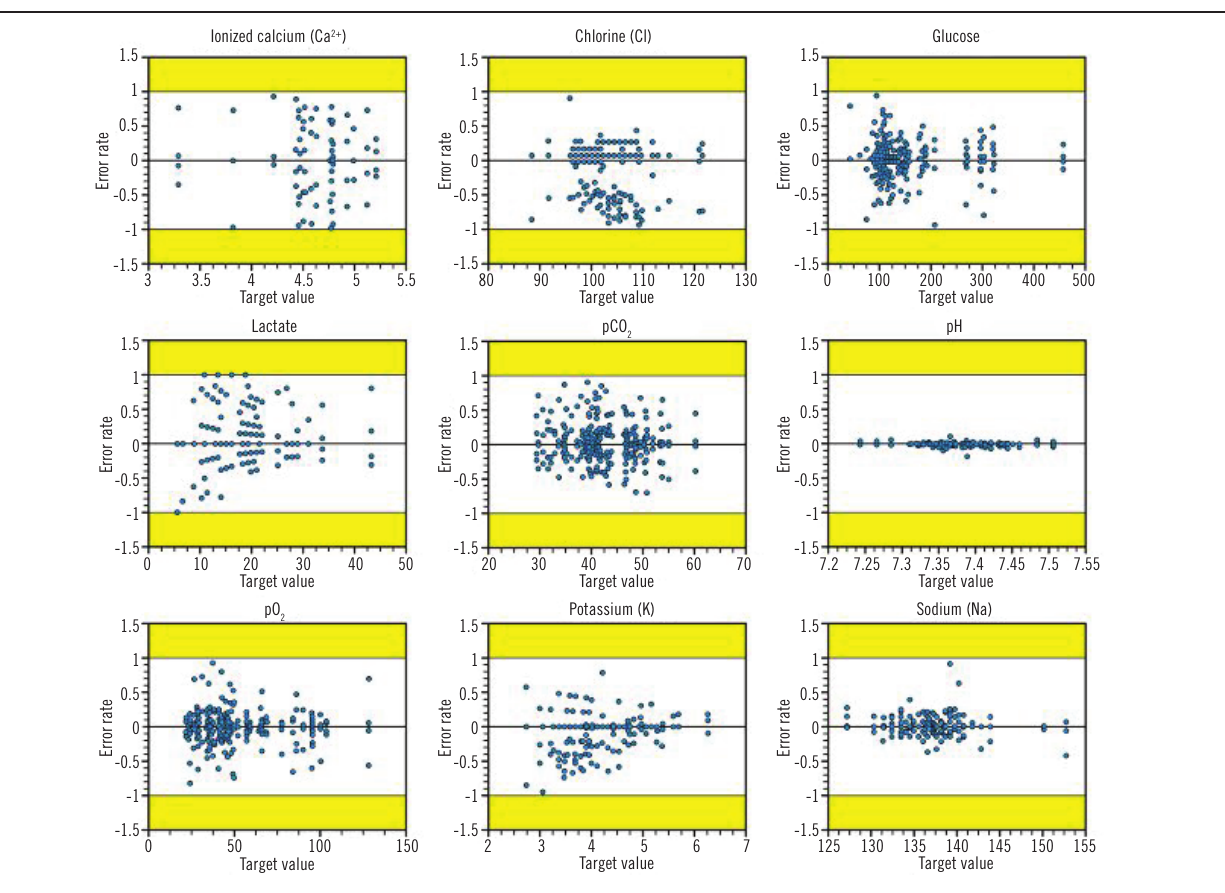
figuRE 2 − Evaluation of error